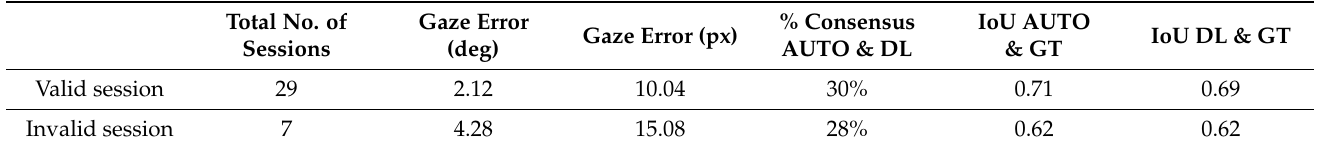
Table 1. Summary of results for valid and invalid sessions. In addition to gaze error metrics, we calculate: (1) percentage of consensus ( IoU > 0.5) between computed pupils’ bounding rectangle by automatic transformation from IR, and the ground truth (manually labeled) in RGB; (2) IoU between computed pupils’ bounding rectangle by automatic transformation from IR, and the ground truth (manually labeled) in RGB; (3) IoU between bounding rectangle computed by deep learning algorithm in RGB, and the ground truth (manually labeled) in RGB.